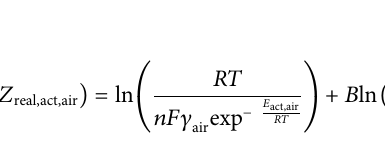
FIGURE 7 | SIMFC model validation comparing measured voltages along I-V curve and simulated values at different working conditions for (A) ASC and (B) ESC con fi guration.